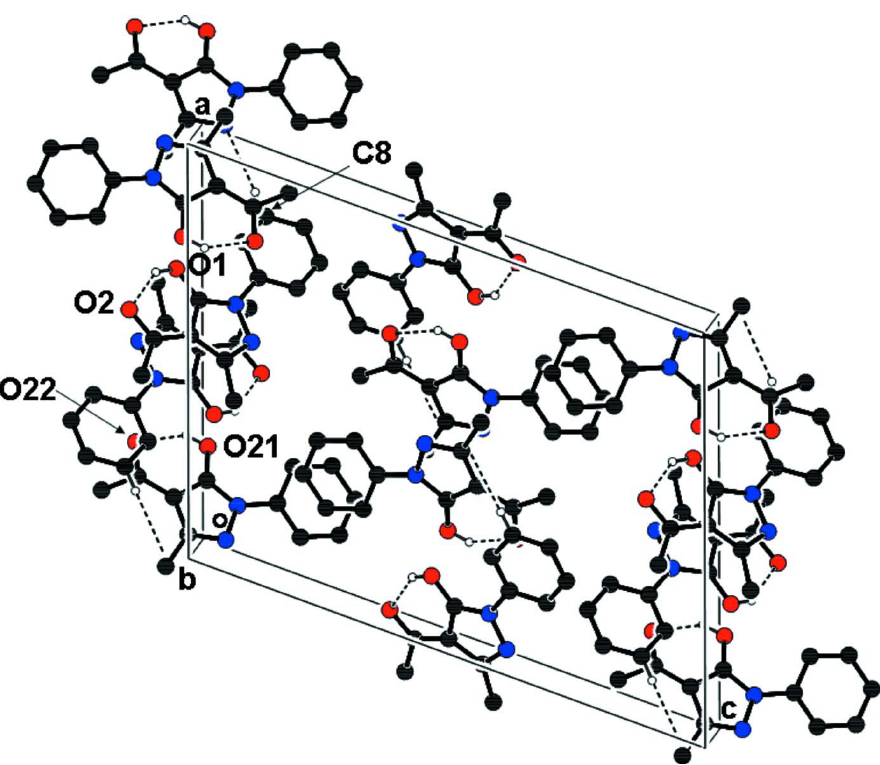
A view along the b axis of the crystal packing, showing the intramolecular O—H···H hydrogen bonds and the intermolecular C—H···N interactions as dashed lines. H atoms not involved in hydrogen bonding have been omitted for